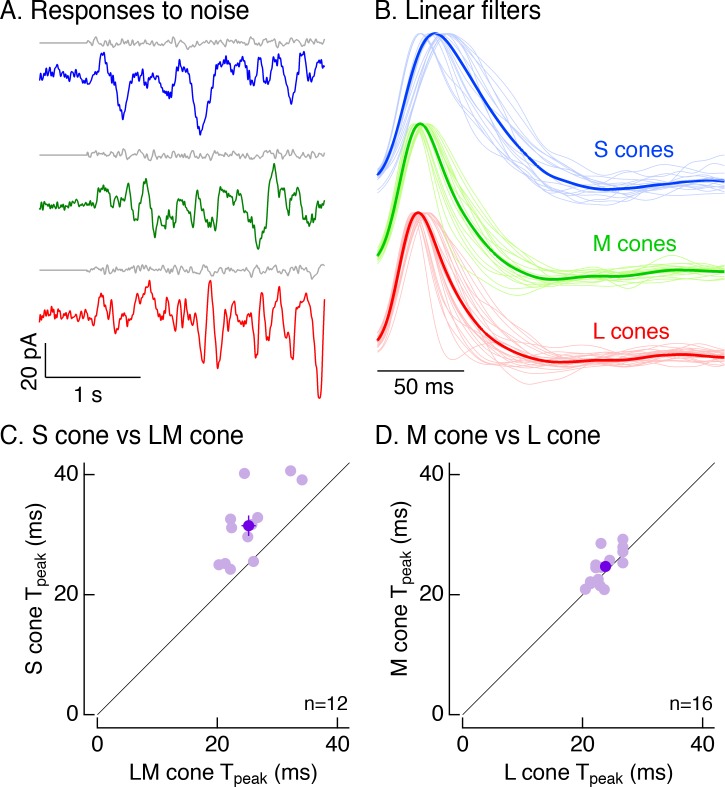
Cone photocurrents differ in kinetics.(A) Example current responses of a voltage-clamped S (top), M (middle) and L (bottom) cone to a short section of Gaussian-modulated light input (gray). The background to which modulation was added produced on average 2500 R*/s in each case. Responses were low-pass filtered digitally with a 100 Hz cutoff. Data in this figure is collected from at least 8 retinas. (B) Normalized linear filters of L, M and S cones on a background of 2500 R*/s. Filters were calculated to be those that optimally map Gaussian-noise stimuli to measured cone responses. Thick traces show average filters, thin traces filters from individual cones (17 S cones, 17 M cones, 24 L cones from nine retinas). (C) Comparison of times to peak of S-cone versus LM-cone linear filters. Each open circle represents the times to peak of filters from an S cone and an L or M cone from the same piece of retina (12 S cones from eight retinas). Closed circle plots mean ±sem. S-cone times to peak were significantly shorter than in LM cones (31.5 ± 2 ms for S cones vs 25.2 ± 1.2 ms for paired LM cones, p<0.005, paired t-test). There are fewer cones here than in B because not every S cone could be paired with an LM cone. (D) Comparison of times to peak of M-cone versus L-cone linear filters as in C. L-and M-cone times to peak were not significantly different (p>0.05, paired t-test; 16 M cones across nine retinas, 24.7 ± 0.7 ms for M cones vs 23.8 ± 0.5 ms for paired L cones).